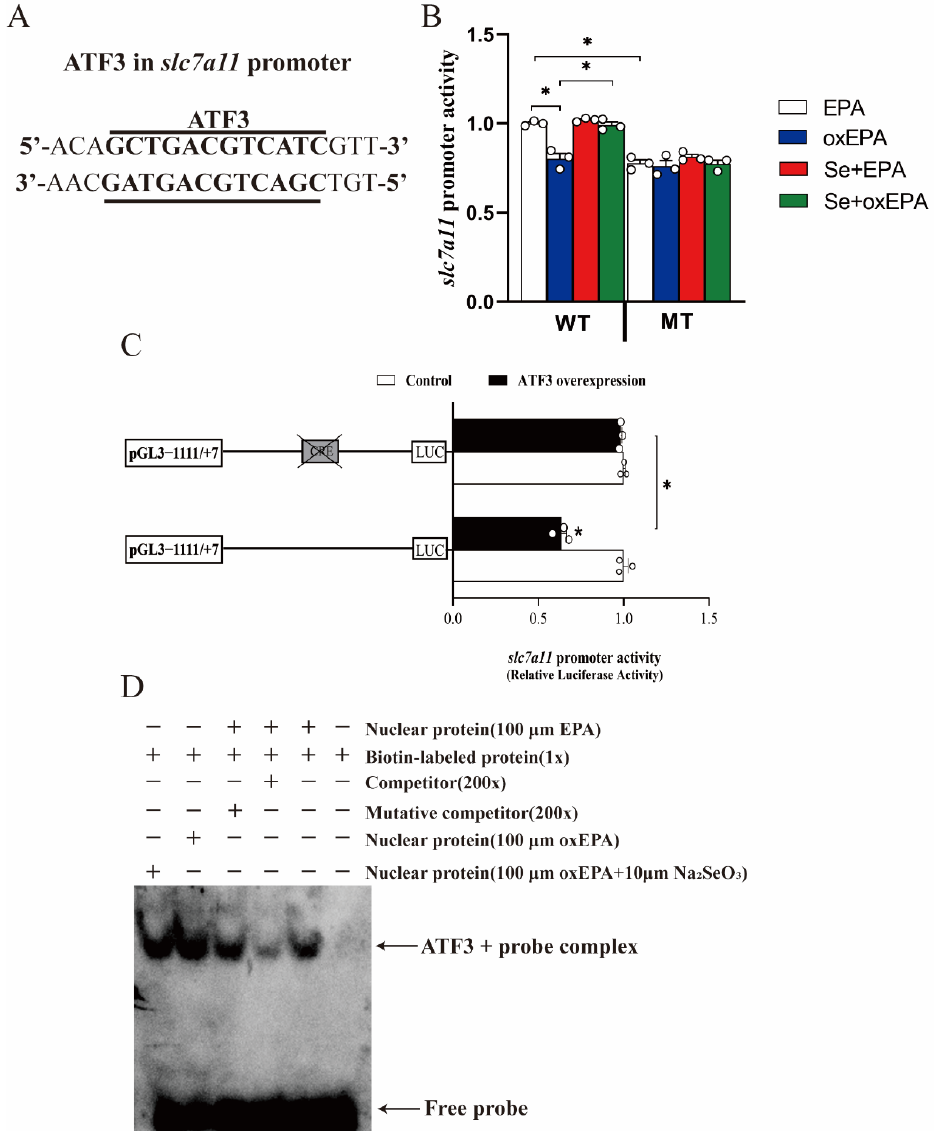
Figure 6. Se and oxEPA affected the SLC7A11 activity by altering the DNA binding capacity of ATF3 to the SLC7A11 promoter in the HEK293T cells. ( A ) Predicted binding site. ( B ) slc7a11 activity assays. ( C ) The luciferase activity assays of predicted ATF3 site after site-directed mutagenesis in the slc7a11 promoter in the HEK293T cells that were treated with an ATF3 overexpression for 24 h. ( D ) EMSA of the predicted binding sequence for slc7a11 promoter for 24 h in the HEK293T cells. All data were mean ± SEM ( n = 3). “*” indicate significant differences at p < 0.05. p value was calculated by Student’s t -test. ATF3, activating transcription factor 3. EPA, eicosapentaenoic acid; MT, mutant type; oxEPA, oxidized eicosapentaenoic acid; SLC7A11, recombinant Solute Carrier Family 7, Member 11; WT, wild